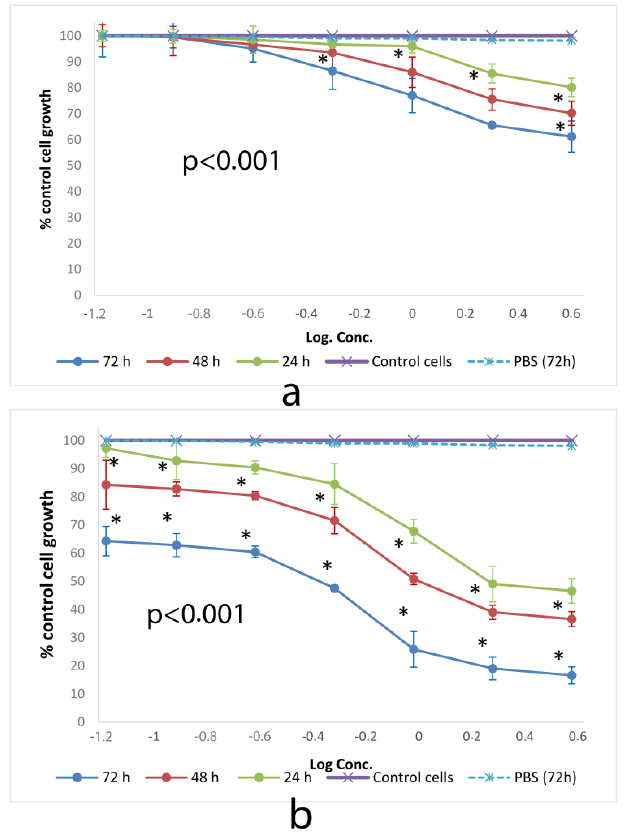
Figure 3. Cytotoxic effect of ( a ) SSM and ( b ) PM at 24, 48 and 72 h on L-929 cell lines determined by SRB assay. Data are representative of tree independent trials and are expressed as the mean ± SD. Significant differences between cell viabilities at 24, 48 and 72 h were indicated by * p <